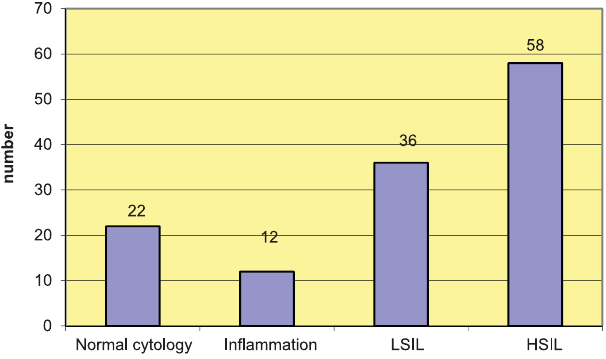
FIGURE 7. Citlogical fi nding. Abnormal colposcopic image